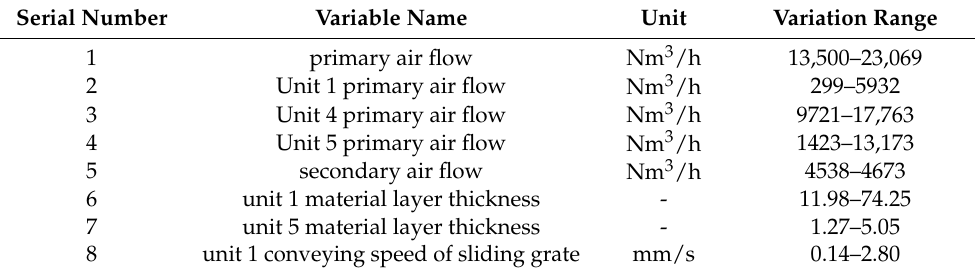
Table 1. Unit and variation range of input variables.